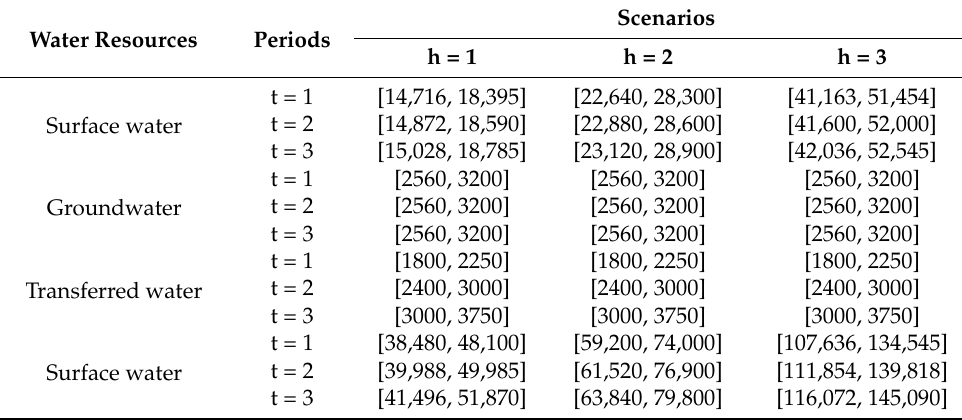
Table 1. Available water resources in the Fenhe River Basin (10 4 m 3 /year). Water